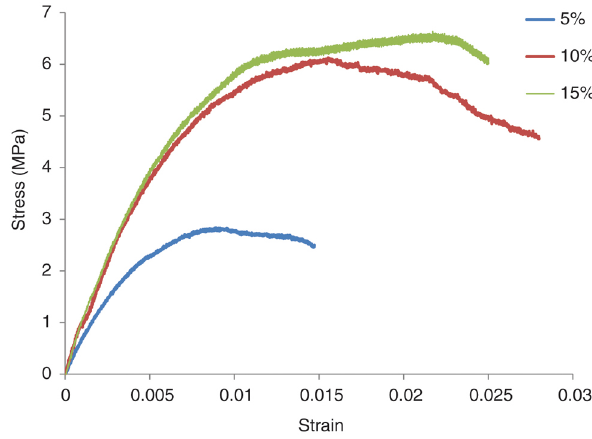
Figure 9: Stress-strain curve for samples prepared at 90°C temperature and 70 bar